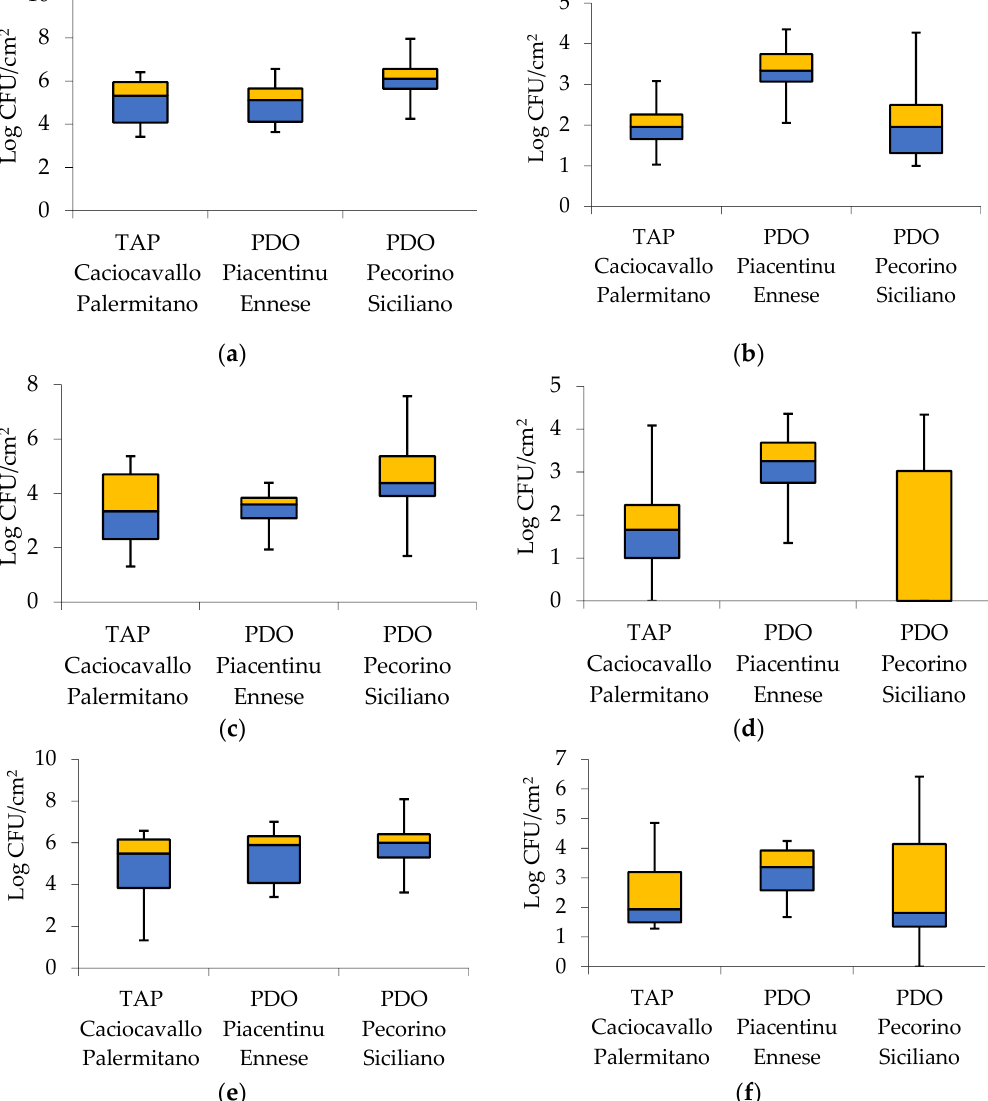
Figure 1. Box and whisker plots of microbial loads of biofilms developed on the wooden shelves used to ripen traditional Sicilian cheeses: ( a ) total mesophilic microorganisms (TMM), ( b ) enterococci, ( c ) mesophilic LAB rods, ( d ) thermophilic LAB rods, ( e ) mesophilic LAB cocci, ( f ) thermophilic LAB cocci. LAB